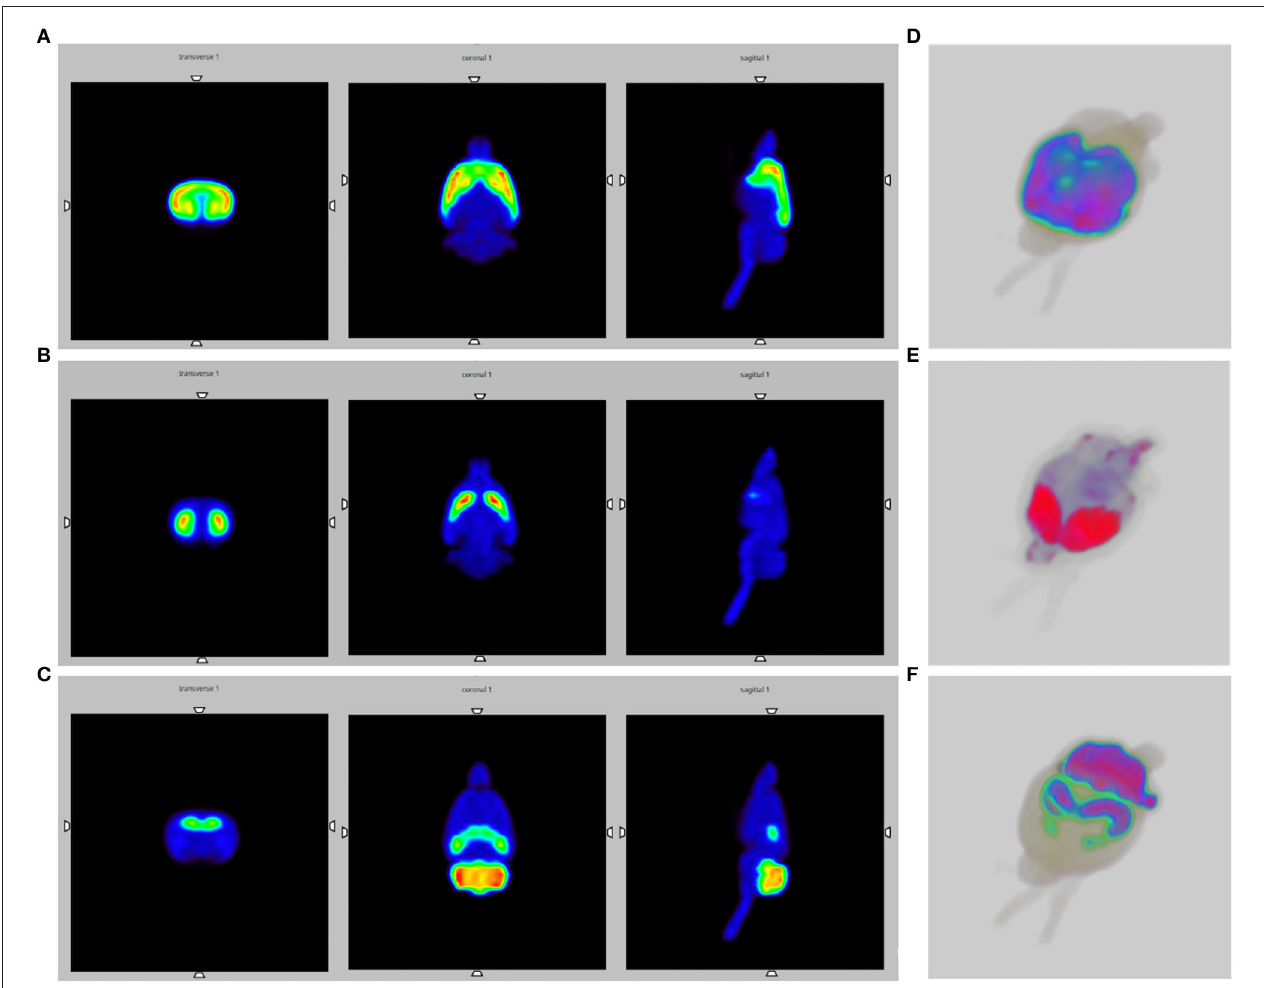
FIGURE 4 | SPECT brain images obtained by Monte Carlo simulations, using the WHS SD Rat Brain V 2.0 phantom. (A) Slice images of the activated striatum and cerebral cortex for the opioid system; (B) Slice images of the activated striatum for the dopaminergic system; (C) Slice images of the activated thalamus, cerebellum and globus pallidus for the endocannabinoid system; (D–F) 3D SPECT